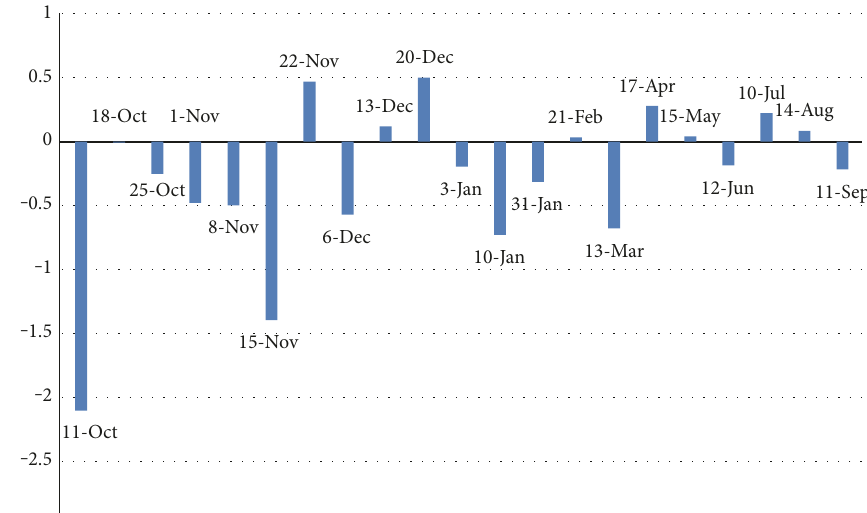
Figure 1: Bar chart showing average weight loss in pounds across participants at each